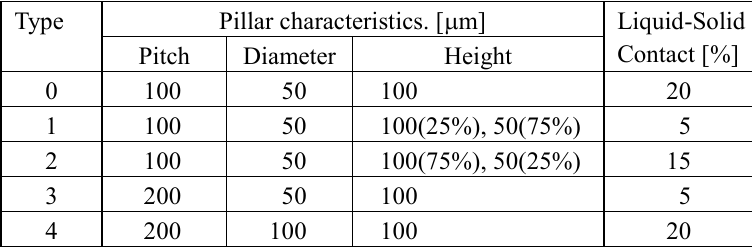
Pillar characteristics. [ µ m]